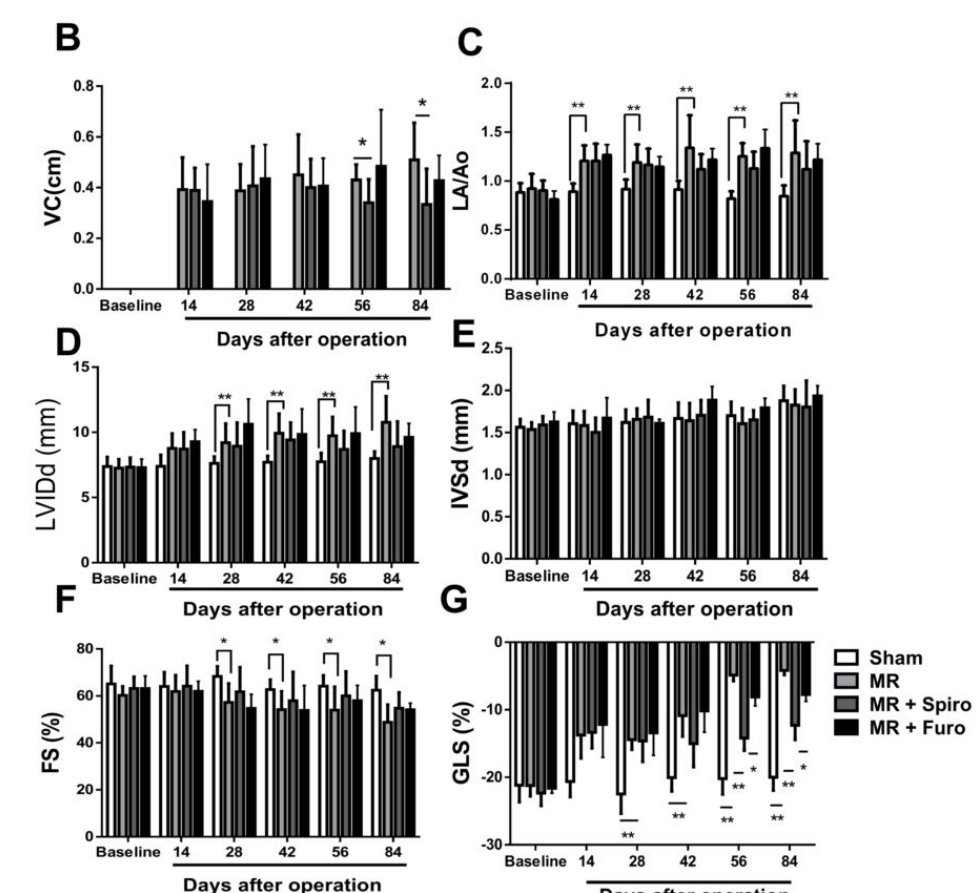
Figure 1. Effect of mineralocorticoid receptor antagonists on the progression of mitral regurgitation (MR) and myocardial dysfunction in a rat model of MR. Heart structure and function were measured by echocardiography at baseline, Day 14 postoperation, Day 28, Day 42, Day 56, and Day 84 post- treatment. ( A ) Illustrations of echocardiographic imaging in the sham, MR, MR+ spironolactone (Spiro), and MR+ furosemide (Furo) groups. ( B ) Echocardiographic measurement results for vena contracta (VC), ( C ) left atrial (LA)/aorta (Ao) size ratio, ( D ) left ventricular internal dimension at end-diastole (LVIDd), ( E ) interventricular septal thickness at end-diastole (IVSd), ( F ) fractional shortening (FS), and ( G ) global longitudinal strain (GLS). Data are expressed as the mean ± standard deviation (S.D.). * p < 0.05, ** p < 0.01 for differences from each